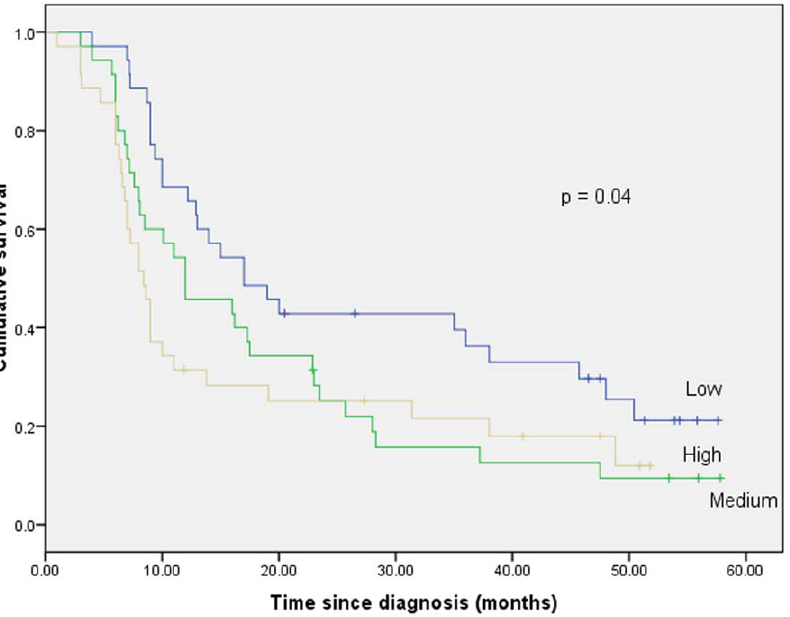
Figure 1. Cumulative survival of GC patients according to whole global (Line-1) blood DNA methylation values.